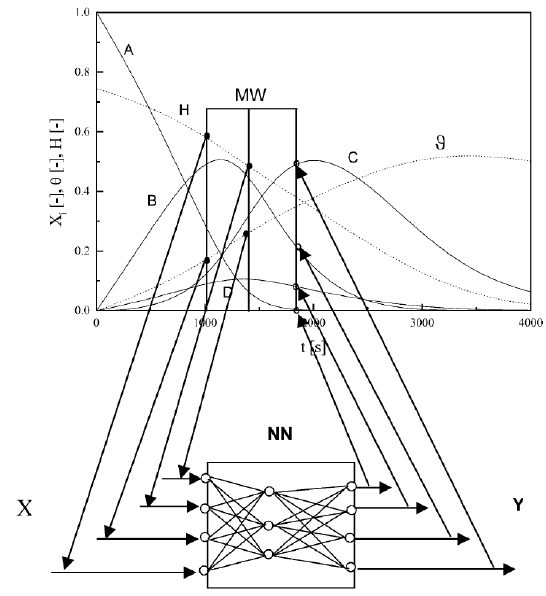
Figure 6. Modeling of the reactor by neural networks with moving time window [54]. X is the vector of input data, Y is vector of output data. Reprinted with permission from Elsevier.